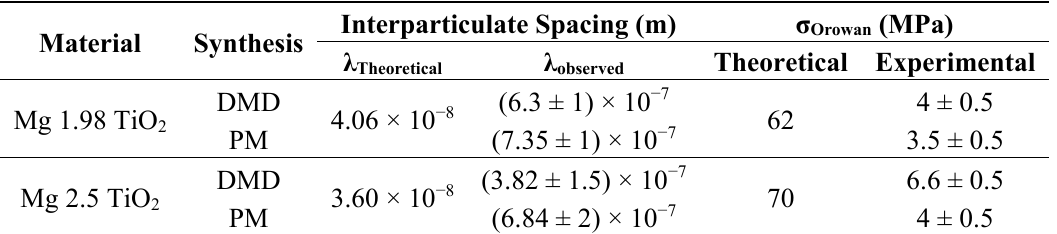
Table 4. Effect of interparticulate spacing between the TiO 2 NPs in the Mg matrix on the Orowan